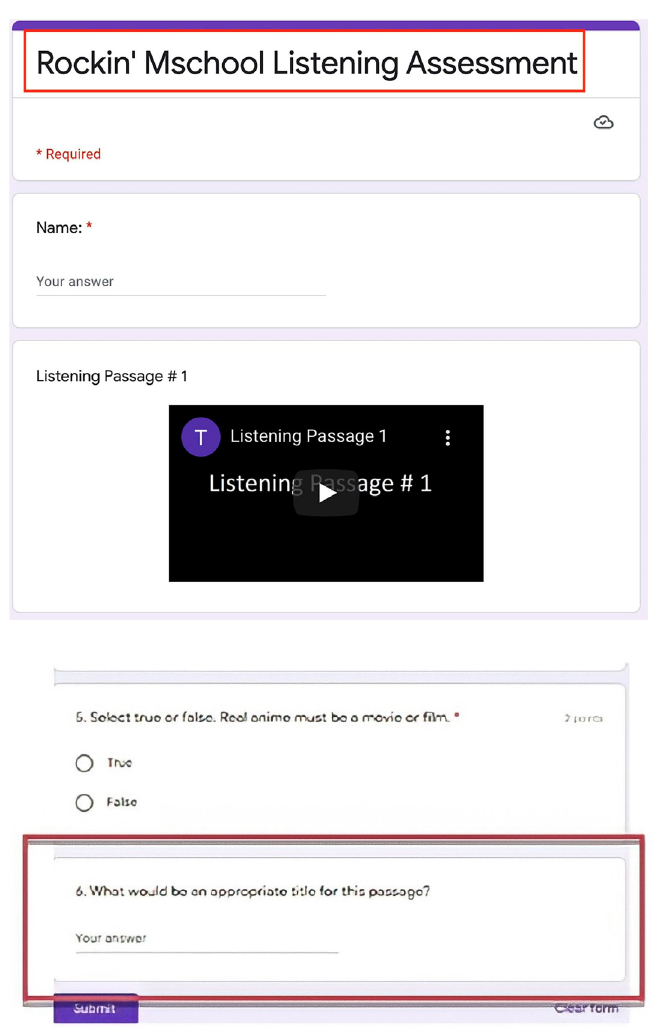
Figure 12. Listening assessment for the seventh-grade. Note: * indicates that a test-taker’s response is required.